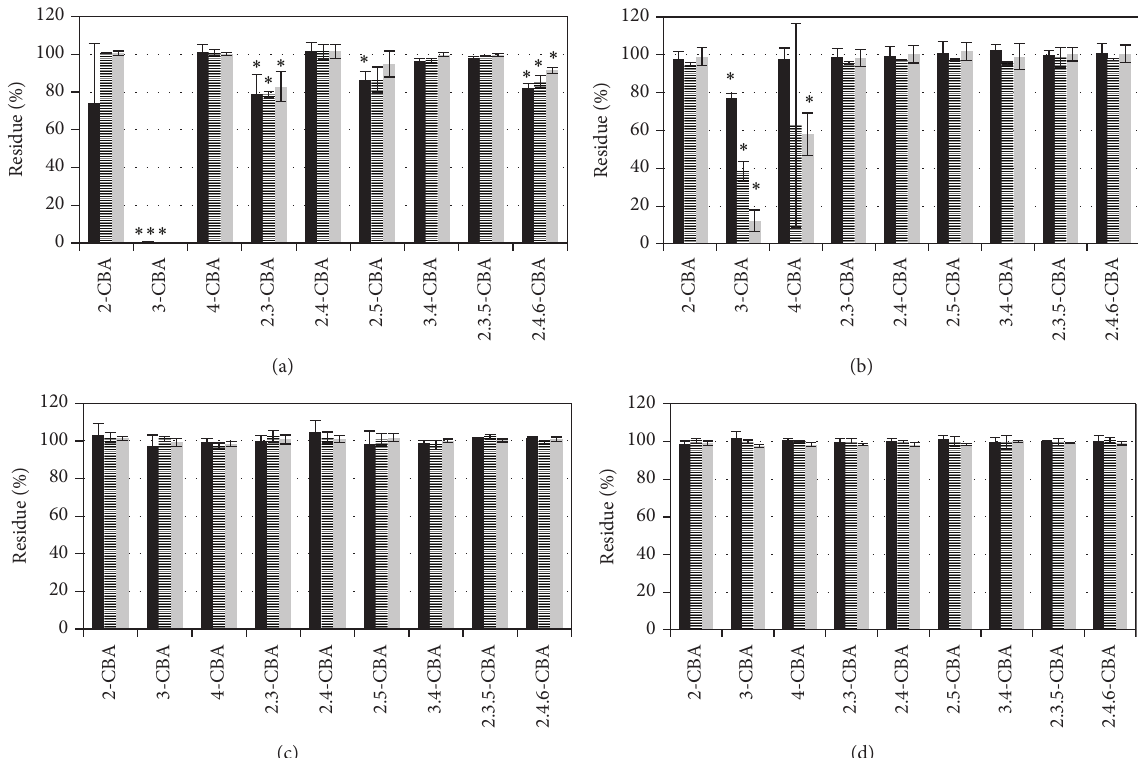
Figure 4: Degradation of single CBA ((a), (c)) and mixture of CBA ((b), (d)) by strains UH222 ( Pandoraea sp.) ((a), (b)) and control ((c), (d)). Black bar in minimal medium, stripped bar in minimal medium with exudates of black nightshade ( Solanum nigrum ), and grey bar in minimal medium with exudates of tobacco ( Nicotiana tabacum ). Stars indicate the statistically significant CBA removal (ANOVA).